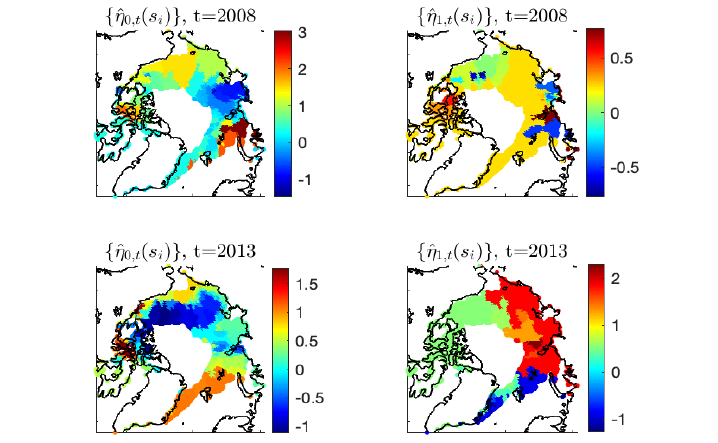
Figure 7. Years 2008 and 2013 are shown. Left panels : The estimates { ˆ p t ( s i | y t − 1 ) } . Middle panels : The estimates { ˆ y t ( s i | y t − 1 ) } using a 0.5 cut-off value to dichotomize { ˆ p t ( s i | y t − 1 ) } . Right panels : The binary Arctic sea ice data derived from satellite data.